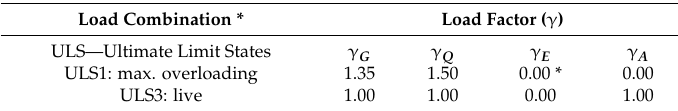
Table 3. Selected